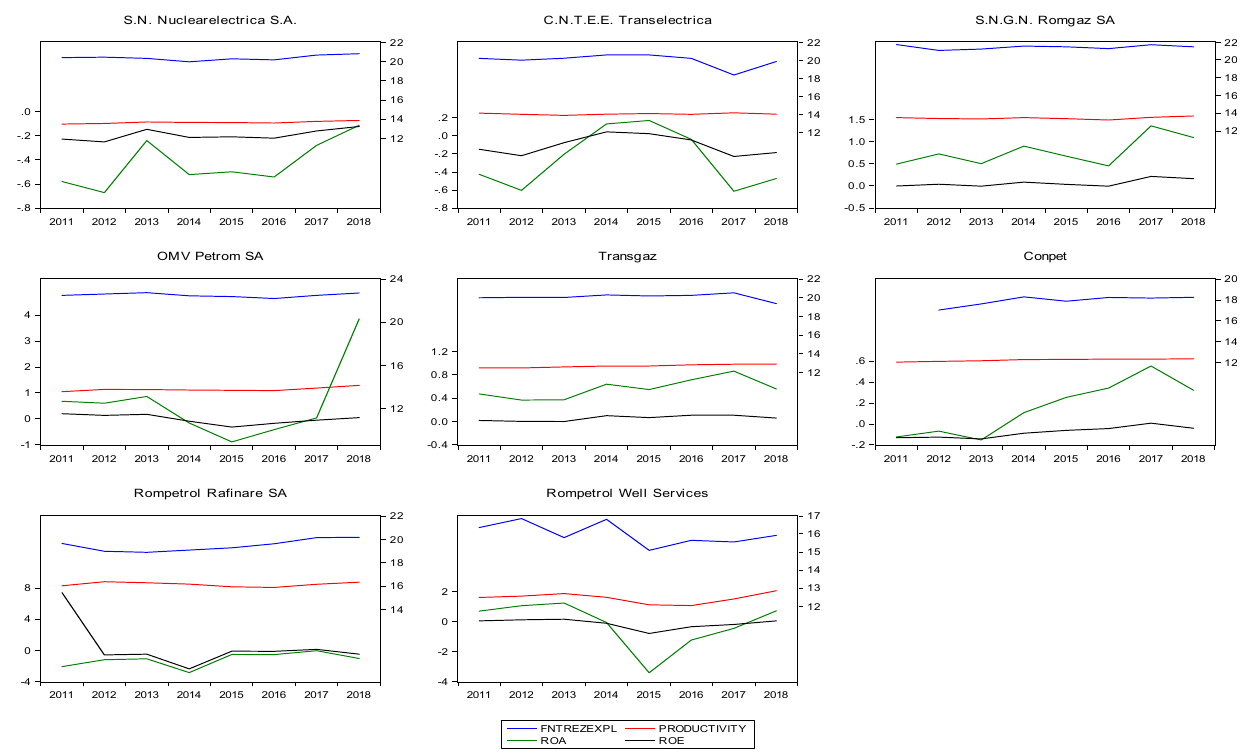
Figure 3. Evolution of the FNTREZEXPL and productivity (right axis) and ROA and ROE (left axis) for the analyzed panel. Source: authors’ construction in Eviews 7.